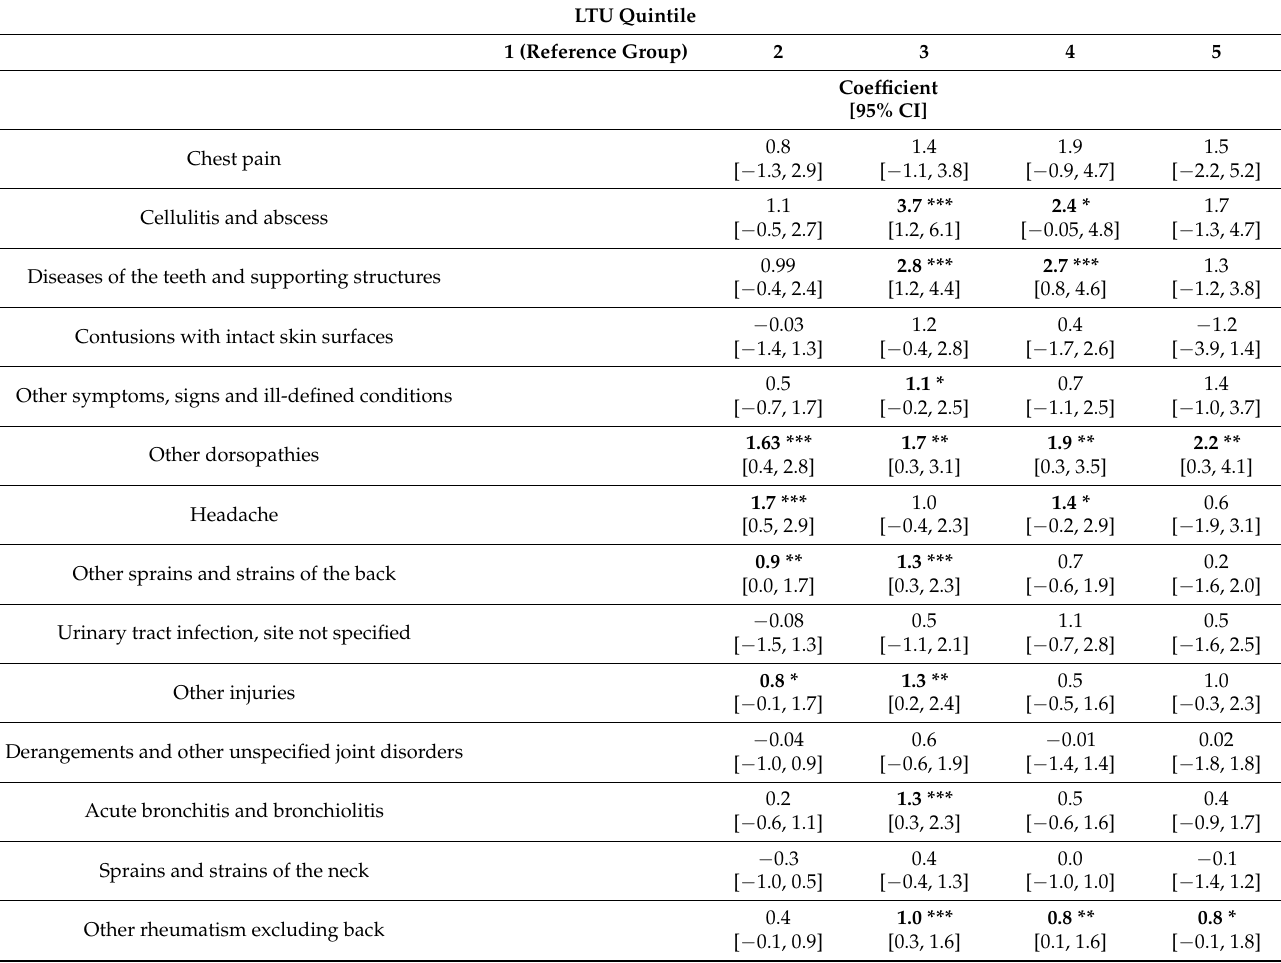
Table 3. Regression Results for 14 Other Top Conditions (ED Visit Rates as the Dependent Variable), South Carolina 2012–2013.